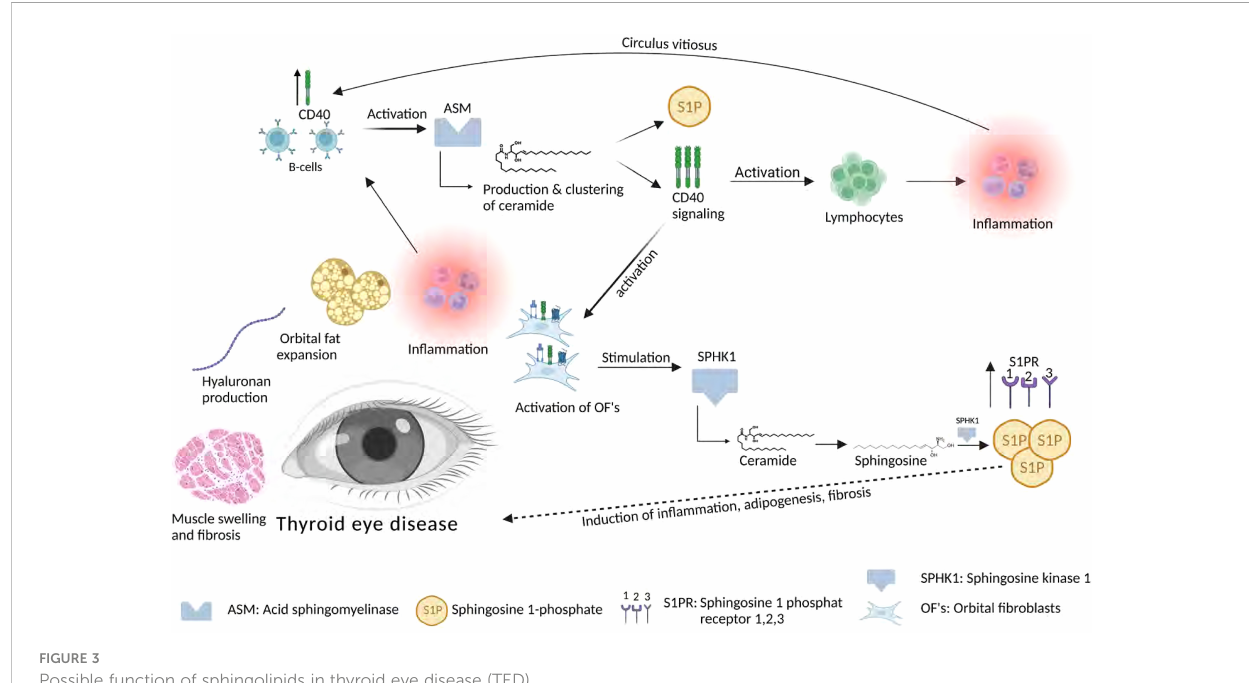
FIGURE 3 Possible function of sphingolipids in thyroid eye disease